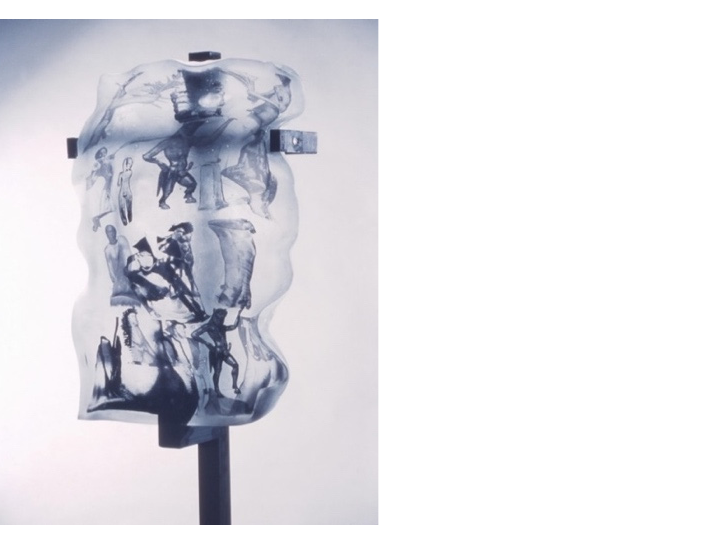
Figure 18. Goshka Bialek; Newspaper , 2002; inclusion of screen-printing images on transfer paper in glass; 180 cm × 50 cm × 30 cm; photo credit: Tim Adams, used with permission.